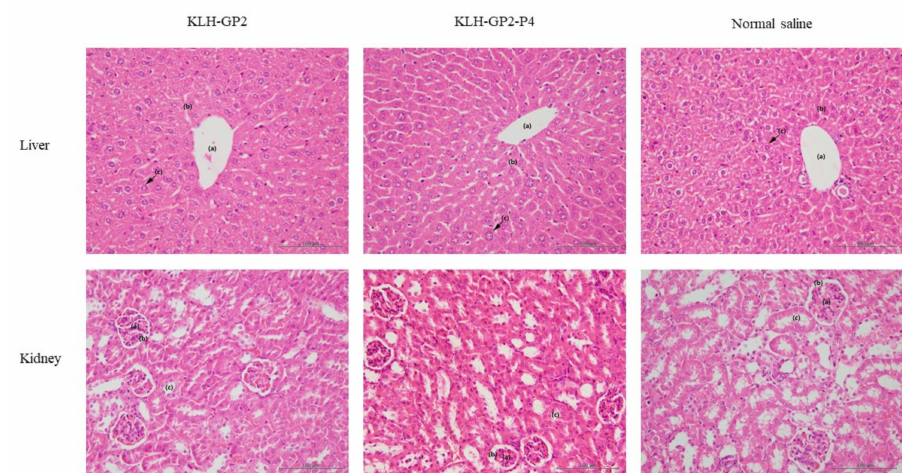
Figure 5. Photomicrographs of liver and kidney sections (H & E stains) from immunized mice. Liver: ( a ) central vein, ( b ) sinusoid and ( c ) hepatocytes. Kidney: ( a ) renal corpuscle, ( b ) capsular space and ( c ) convoluted tubule. Scale bar: 100 µ